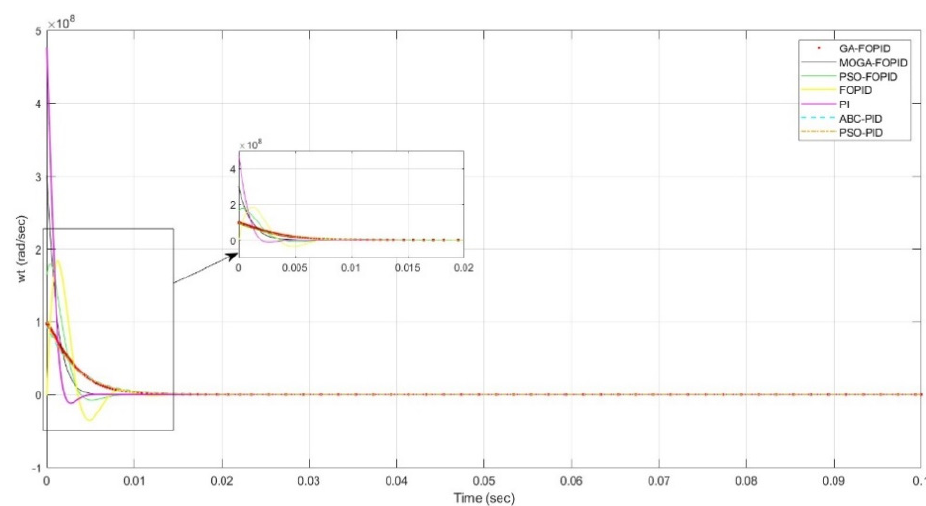
Figure 5. The control signal of the wind turbine model for a step reference.